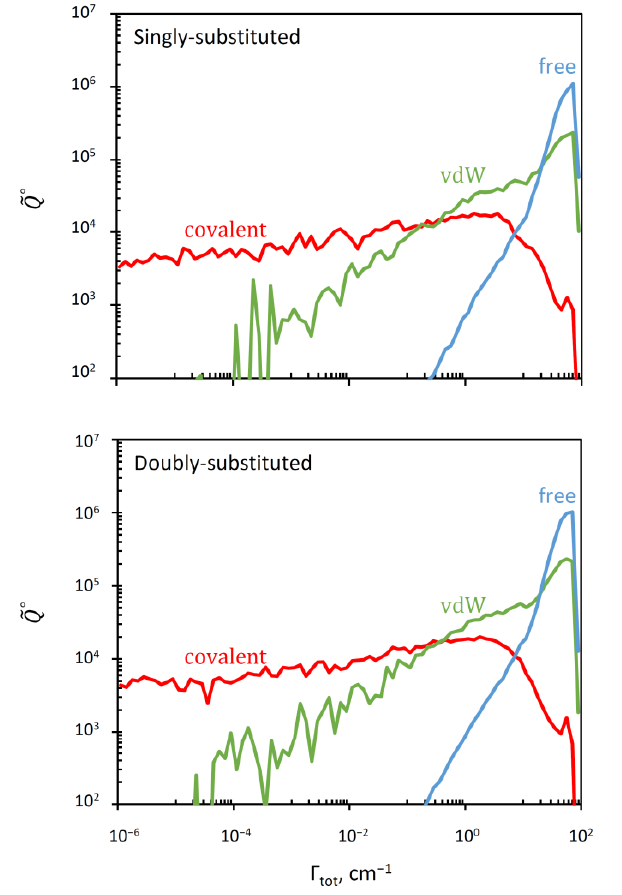
Figure 5. Deconvolution of the overall distribution of resonance widths (given in Figure 3) onto three components that correspond to the covalent well states ( red ), van der Waals plateau states ( green ), and the continuum states in the asymptotic region of the PES ( blue ). The cases of single and double isotopic substitutions are given in the upper and lower frames, respectively.